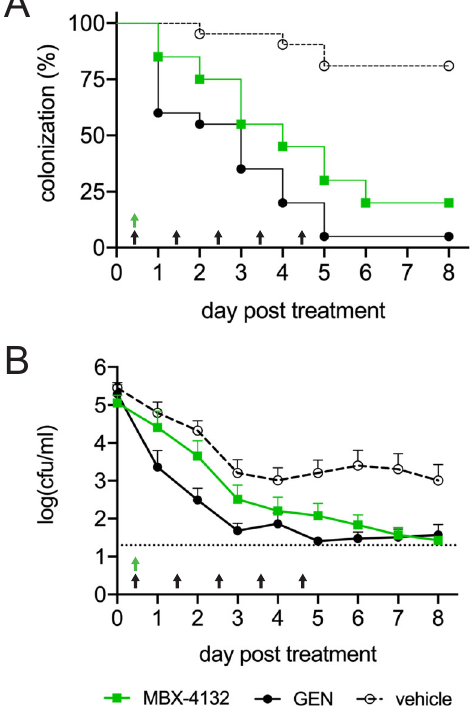
Fig. 2 MBX-4132 clears infection by a multiple-antibiotic resistant N. gonorrhoeae strain in a murine infection model. Mice were infected with N. gonorrhoeae H041 for two days and treated with a single oral dose of 10 mg/kg MBX-4132 or vehicle on day 0 (green arrow), ( n = 20 mice for MBX-4132 and n = 21 mice for vehicle). As a positive control, 48 mg/kg gentamicin (GEN) was administered by intraperitoneal injection beginning on day 0 (5QD, black arrows). A The percentage of infected mice over 8 days post-treatment. Mice that were culture-negative for at least 3 consecutive days were considered to have cleared infection. MBX-4132 and GEN signi fi cantly reduced the percent of infected mice compared to vehicle (Mantel-Cox, p < 0.0001). B Mean bacterial burden (cfu/ml) recovered daily following treatment on day 0. MBX-4132 and GEN signi fi cantly reduced the bacterial burden compared to vehicle (2-way ANOVA with Bonferroni for multiple comparisons, p < 0.0001). Limit of detection (20 cfu/ml) is denoted by the horizontal dashed line. Error bars indicate standard error of the mean. Source data are provided as a Source Data fi